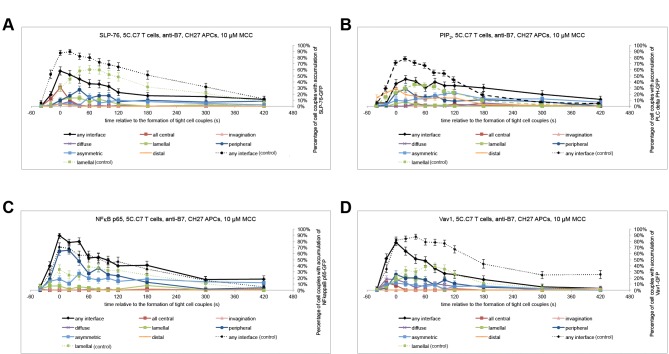
Costimulation blockade diminishes recruitment of signaling intermediates to the lamellal pattern.5C.C7 T cells were activated by CH27 APCs and 10 μM MCC peptide upon costimulation blockade with 10 μg/ml anti-CD80 and anti-CD86. The percentage of T cells showing accumulation in defined patterns among all cell couples analyzed across multiple experiments are shown similar to Fig 5D for (A) SLP-76-GFP (number of cell couples analyzed across multiple independent experiments, n = 52) (B) PLCδPH-GFP (PIP2 sensor) (n = 59), (C) NFκB p65 (n = 55), and (D) Vav1-GFP (n = 51). Broken lines indicate interface accumulation under control conditions as a reference (Figs 1E, 1F and 4D of the accompanying manuscript and Fig 3C in [24]). Error bars are s.e.m..